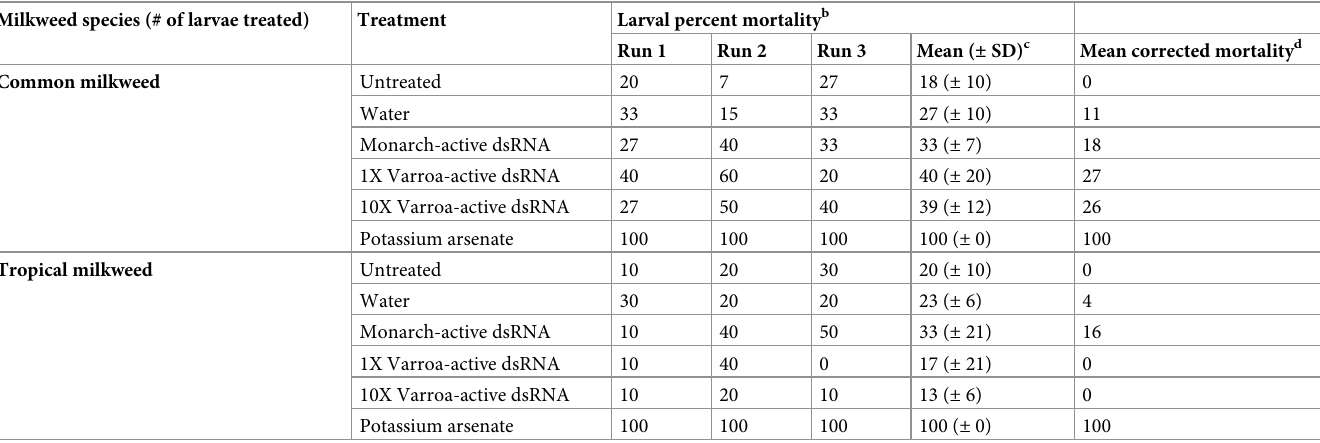
Table 2. Monarch larval percent mortality following treatment with Varroa-active dsRNA and two positive and two negative controls a . Milkweed species (# of larvae